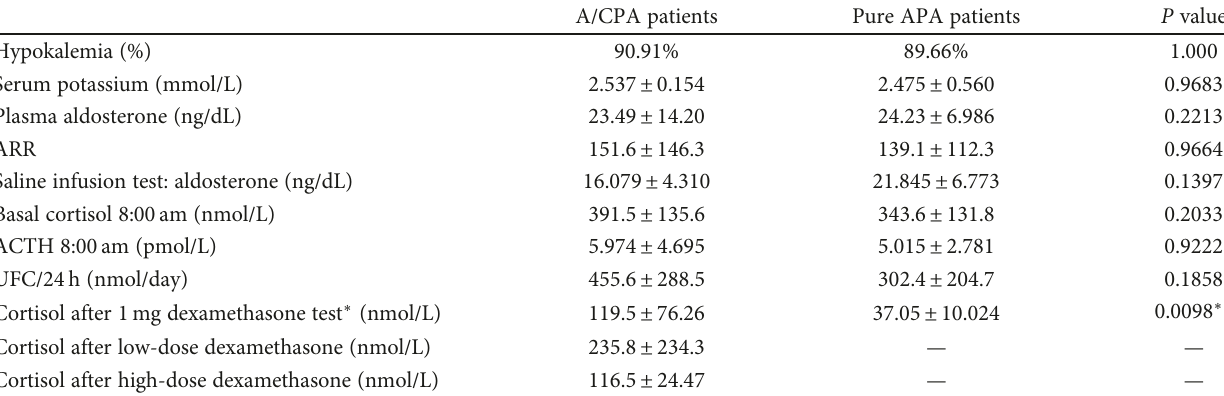
Table 2: Baseline biochemical and hormonal parameters of A/CPA and pure APA patients.